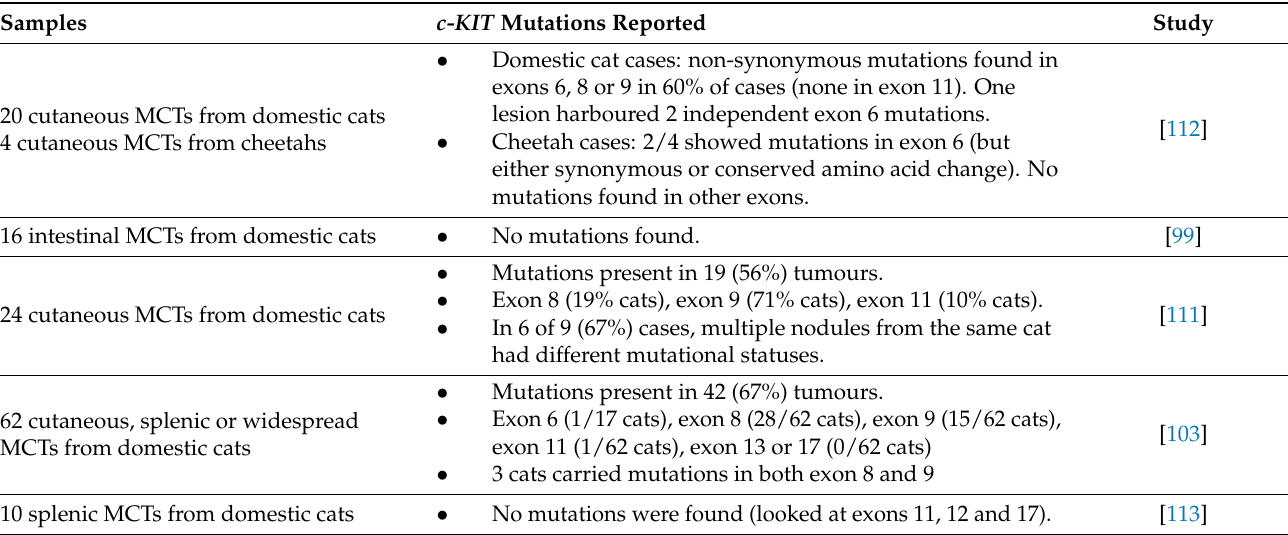
Table 3. A summary of the studies that have analysed the c-KIT gene in feline MCTs. The Kit protein is composed of an extracellular domain, consisting of 5 immunoglobulin-like domains (encoded by exons 1–9), a transmembrane domain (exon 10) and an intracellular domain (exons 11–21), which contains a negative regulatory juxtamembrane domain (exons 11–12) and a cytoplasmic tyrosine kinase domain (exon 13 and